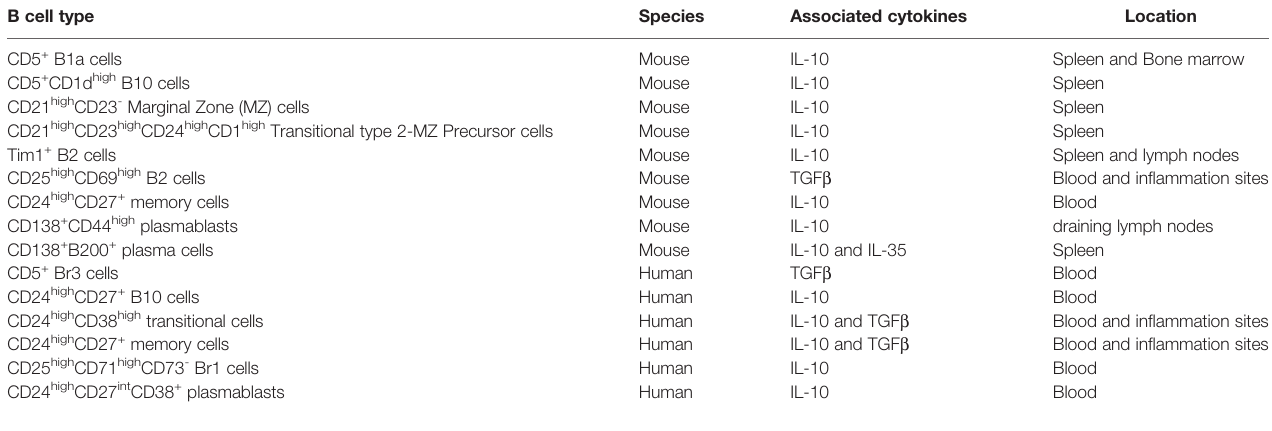
TABLE 1 | Diverse regulatory B cell subsets. B cell